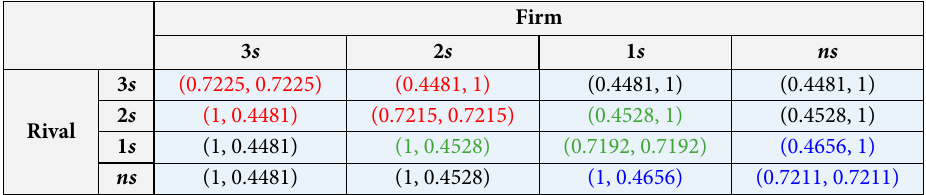
Table 4. Technological transition: two observations, risk-averse DM, and signals on X 1